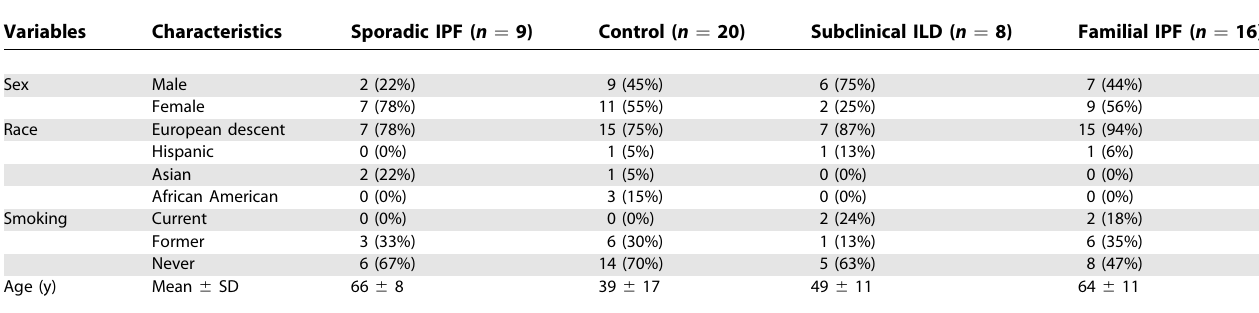
Table 2. Validation Cohort Patient